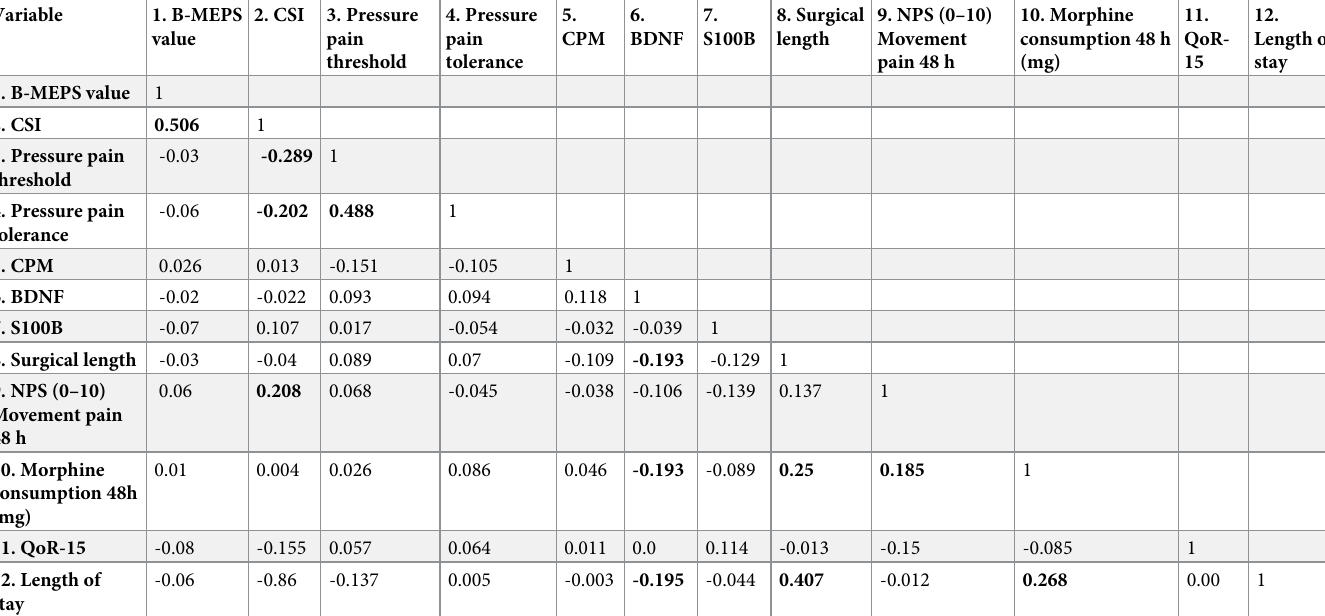
Table 3. Spearman’s rank correlation matrix for preoperative, transoperative, and postoperative variables. Variable